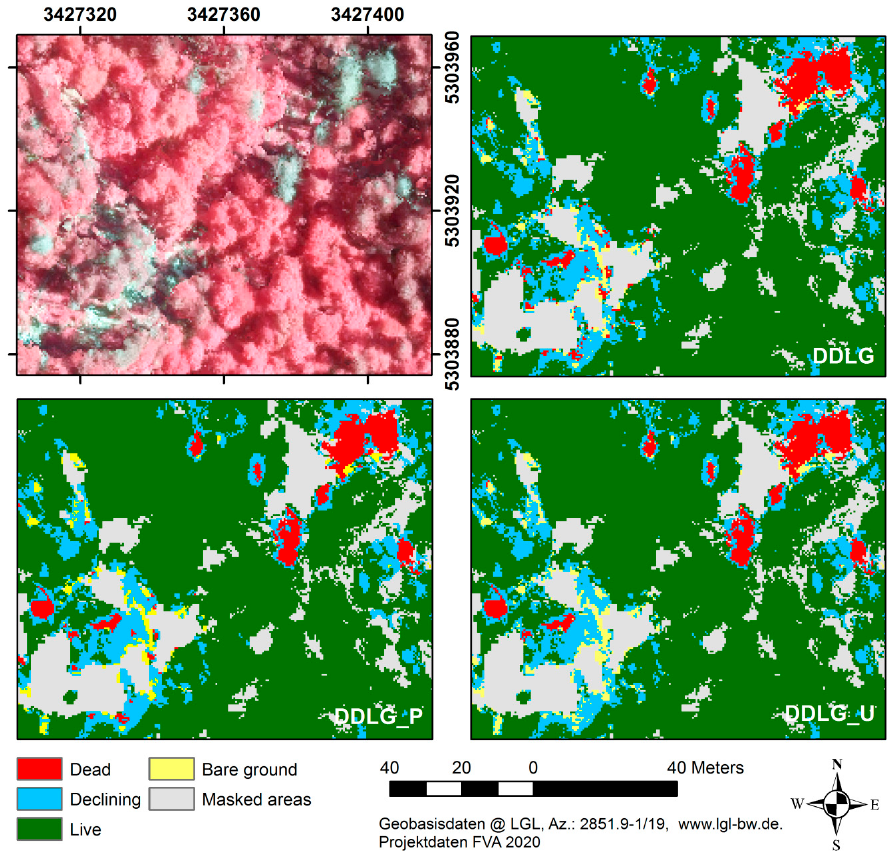
Figure 4. Examples of the results obtained with different classification scenarios: Random forest (RF) classification (DDLG), RF classification with post-processing (DDLG_P), and with additional deadwood-uncertainty filter (DDLG_U), compared to the input CIR aerial imagery (upper left). Note the reduction of isolated pixels in DDLG_P and the improved “bare ground” recognition in DDLG_P and DDLG_U compared to DDLG (lower left corner).